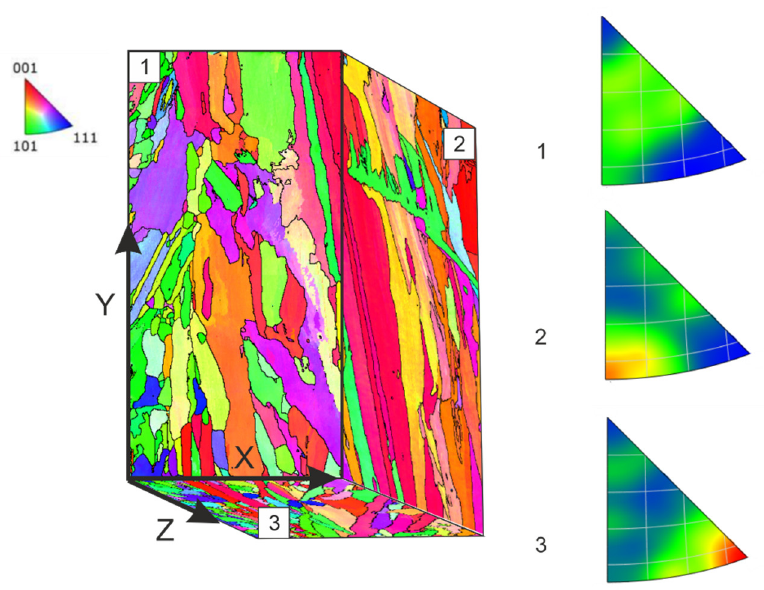
Figure 1. The orientation grains maps relative to the Y axis of three mutually perpendicular faces of the sample in colors IPF and 1, 2 and 3 faces IPF relative to the Y axis.